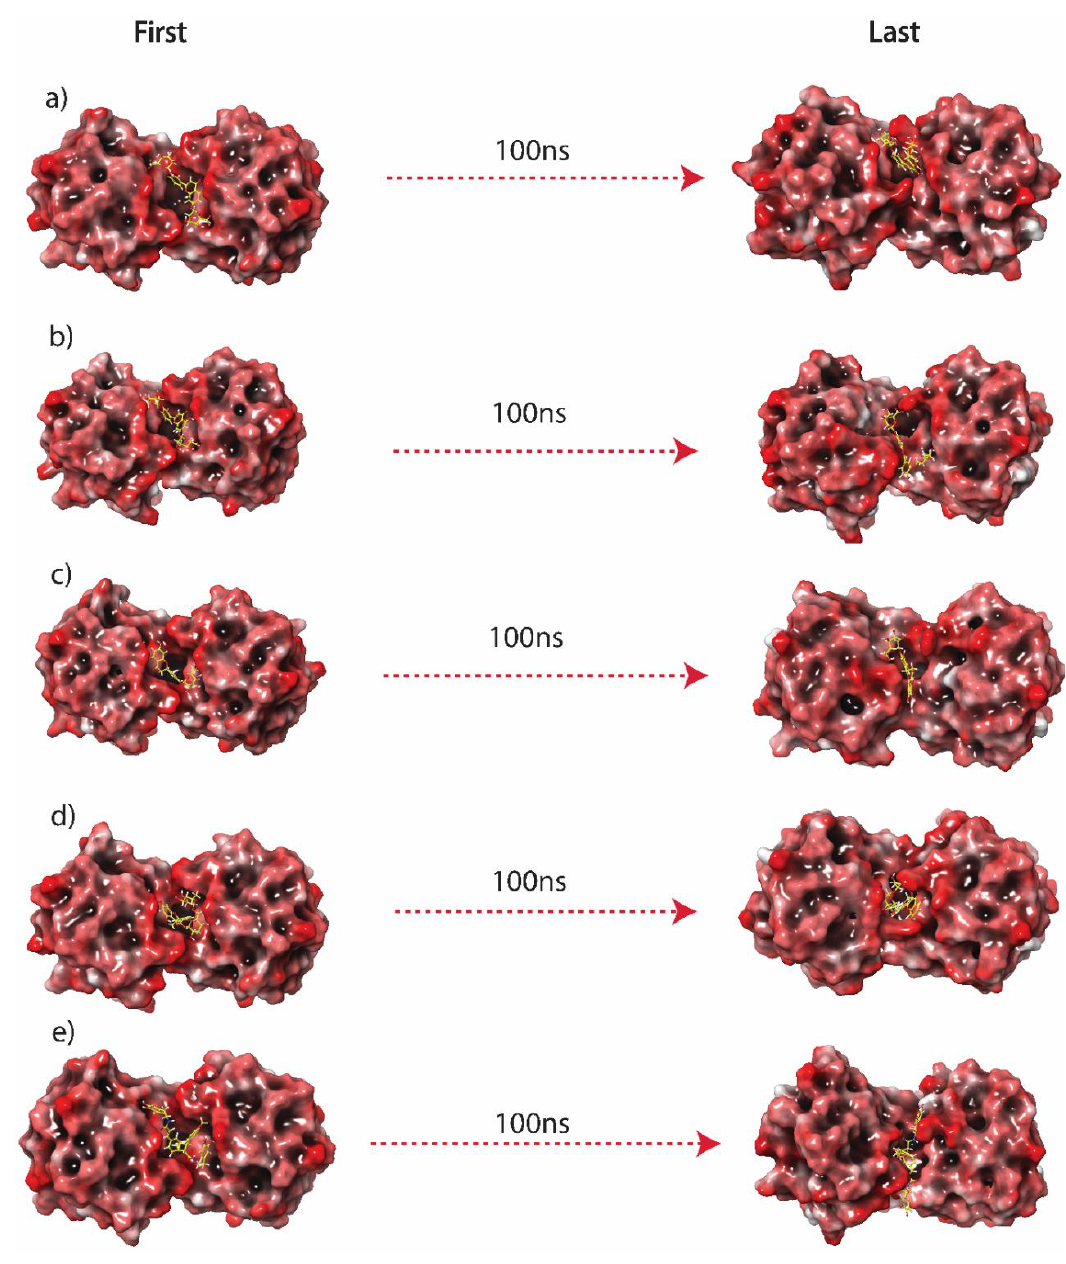
Figure 3. Representation of the 3D surface conformational changes in the last poses, i.e., ( a ) Luteolin 7,3 ′ -diglucuronide, ( b ) Luteolin 7-glucuronide-3 ′ -glucoside, ( c ) Plantagoside, ( d ) Narcissoside, ( e ) (alphaE,8S,9R)-N-(3,4-Dihydroxyphenethyl)-8-[(3,4-dihydroxyphenethyl)carbamoyl]-9-(1,3-benzodioxole-5-yl)-3aalpha,7aalpha-ethano-1,3-benzodioxole-5-acrylamide, extracted from the 100 ns MD simulation trajectories in comparison to the respective docked poses.